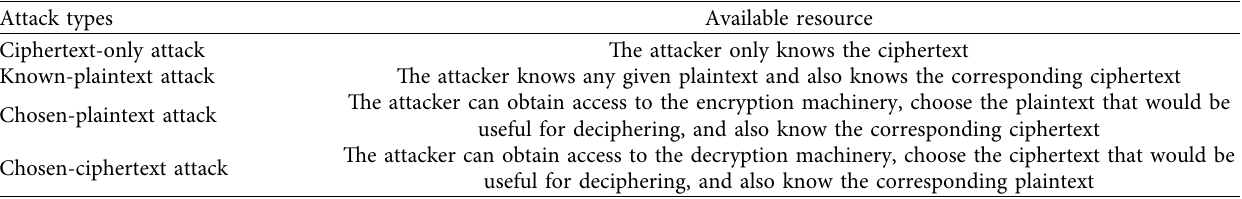
Table 1: Four common attack types for cryptanalysis.